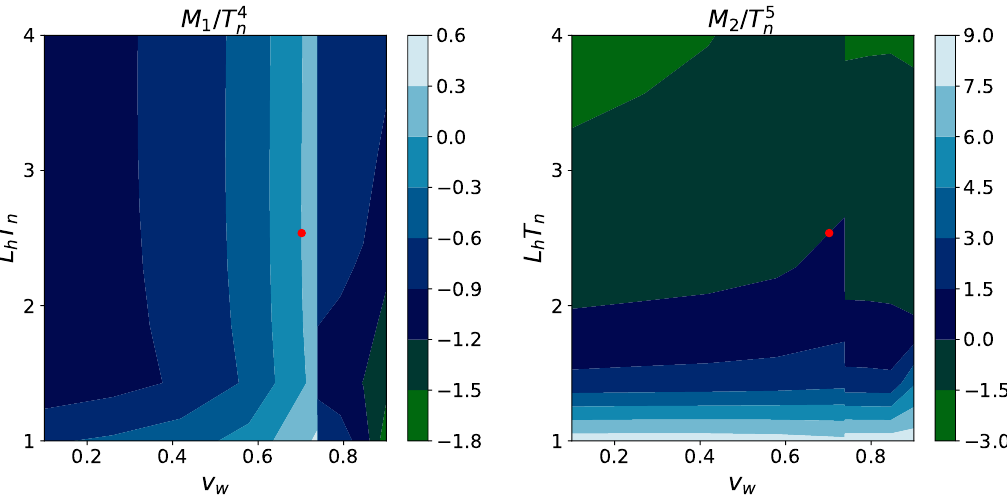
Figure 4 . Moment grid for a model with m s = 80 GeV, λ hs = 0 . 84 and λ s = 1 . The red point gives the minimum of the quadrature f ( v